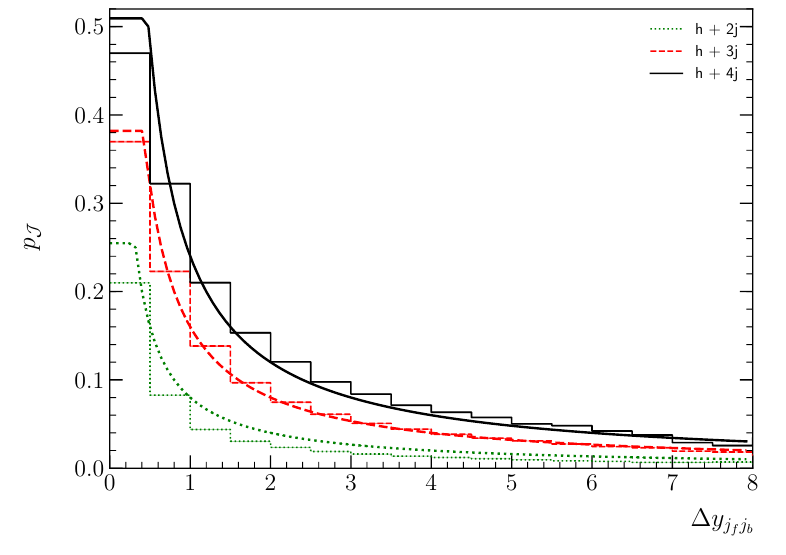
Figure 5. Estimated probability for an extra emission to end up inside a jet compared to the fraction observed in the exclusive production of a Higgs boson with two (green dotted line), three (red dashed line), and four (black solid line)